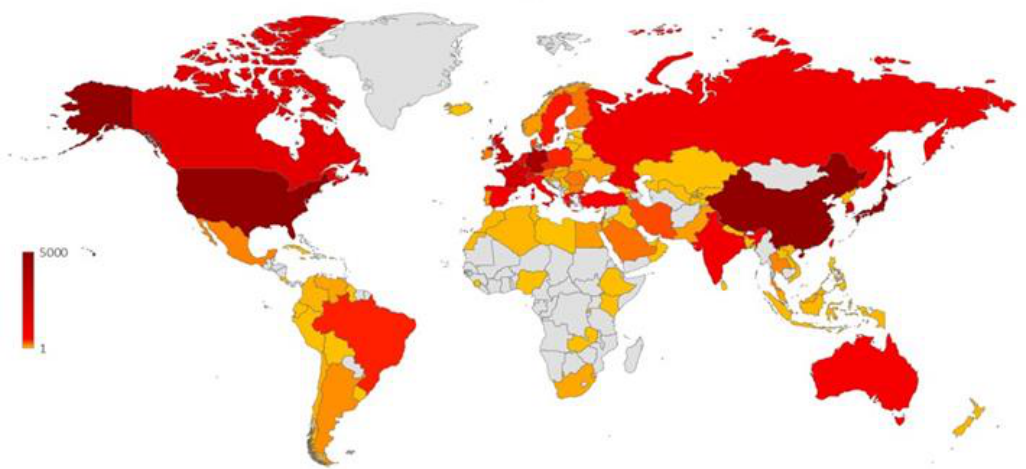
Figure 5. World map with main countries and their number of publications on block copolymers. The deep red color indicates the countries with the biggest number of publications, the yellow indicates smaller numbers of publications, and the gray indicates the countries without any publications.